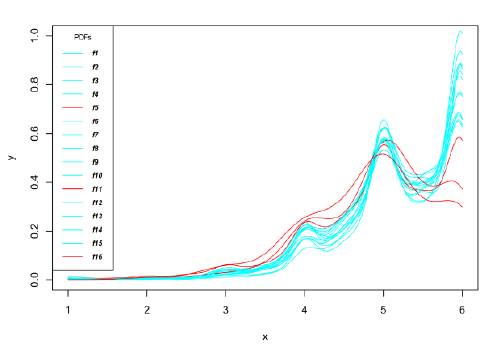
Fig. 5: The clustering result of sixteen PDFs in example 2 by non-hierarchical algorithm in R.